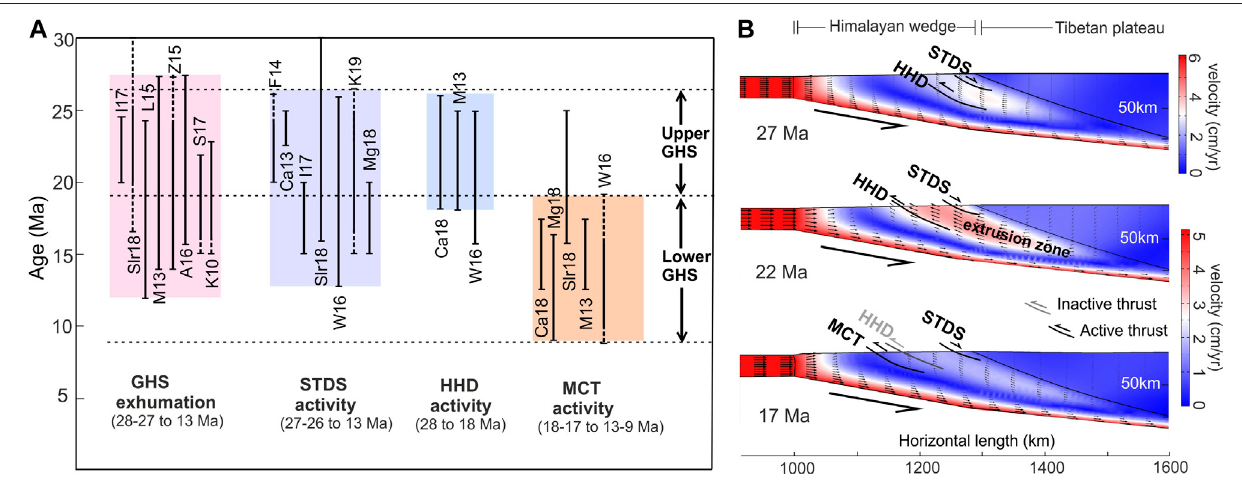
FIGURE 8 | (A) Graphical plots of the geological ages of GHS exhumation and associated crustal scale shear zones (STDS, HHD, and MCT) in the Himalaya, compiledfromavailablerecentliterature(I17:Iaccarinoetal.,2017;Slr18:SoucyLaRocheetal.,2018;L15:Leloupetal.,2015;M13:Montomolietal.,2013;Z15:Zeiger et al., 2015; A16: Agustsson et al. 2016; S17: Shrestha et al., 2017; K10: Kellet et al., 2010; F14: Finch et al. 2014; Ca13: Carosi et al. 2013; W16: Wang et al., 2016; K19:Kellettetal.,2019;Mg18:Montemagnietal.,2018;Ca18:Carosietal.2018).( B )NumericalmodelshowinginitiationoftheGHSexhumationzone,withSTDS (extensional) and HHD (thrust) asthe northern and southern bounding surfaces, followed bysouthward migration of its southern shear boundary to form MCT at 17 Ma. The convergence velocity was 6-5.5 cm/yr at 27 Ma, and 5 cm/yr at 22 Ma.